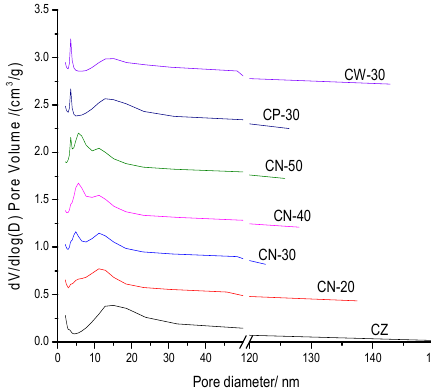
4.36 1 : micropore surface area and external surface area, from t ‐ plot; 2 : single ‐ point adsorption total pore volume of pores; 3 : micropore volume, from t ‐ plot; and 4 : mesopore volume, from the BJH method. The pore distribution of the catalysts is shown in Figure 9. It can be concluded that the binder content and molding method have an important influence on the pore size distribution of catalysts [26]. In addition to the micropore of HZSM ‐ 5 itself there is a concentrated mesopore distribution formed at about 15 nm for CZ, which is due to the formation of large intercrystal mesopores. The concentrated mesopore distribution of CN ‐ 20 shifted to a low pore diameter, indicating that the addition of the binder changed the interaction of HZSM ‐ 5 crystals. There are two kinds of concentrated pore distribution at about 4.79 nm and 11.28 nm for CN ‐ 30 in addition to 5.57 nm and 11.28 nm for CN ‐ 40 and CN ‐ 50. Besides, there is a concentrated pore distribution at about 3.45 nm for CN ‐ 50, which may be formed by the binders due to the high binder content. With an increase in binder content a hierarchical pore distribution was formed. Different from CN series catalysts, CP ‐ 30 and CW ‐ 30 have similar pore distribution, with two kinds of concen ‐ trated pore distribution at about 3.45 nm and 13.84 nm. The number of pores at 3.45 nm for CP ‐ 30 and CW ‐ 30 is higher than CN ‐ 30, which is similar to CN ‐ 50; this may be due to